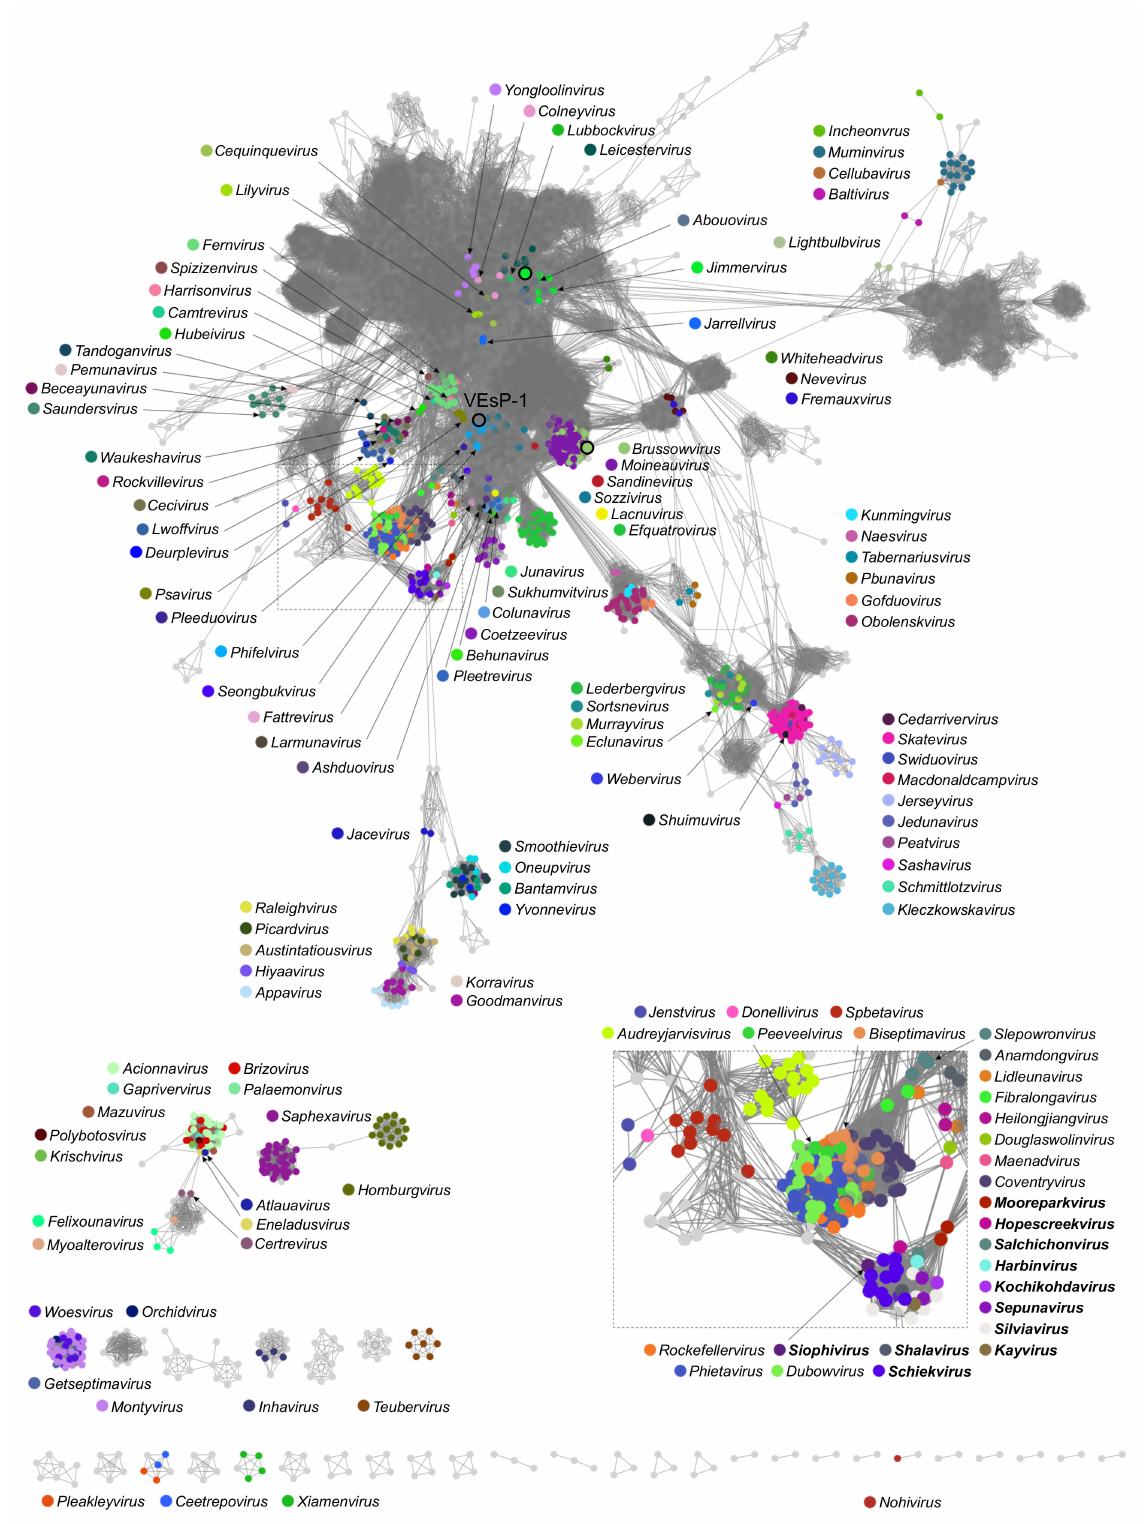
Figure 3. Network analysis of bacteriophage genomes. The inset shows a part of the network containing Herelleviridae members (given in boldface). The circles with outer boundaries show starting points for BLAST searches: Enterococcus phage VEsP-1, Streptococcus phage P7954 ( Brussowvirus ), and Brevibacillus phage Powder ( Jimmervirus ). The network was calculated in vContact2 0.11.3 and visualized with the use of Cytoscape 3.9.1